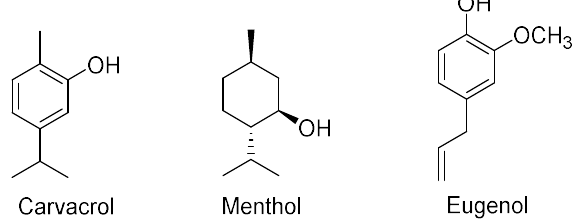
Figure 6. Structures of further essential oils.